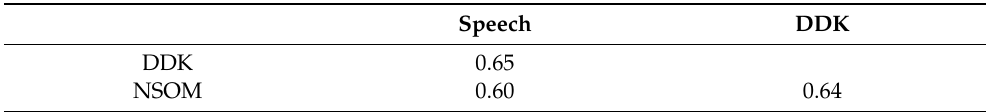
Table A9. Between-factor correlations for the three CFA factors corresponding with the EGA dimen- sions plotted in Figure